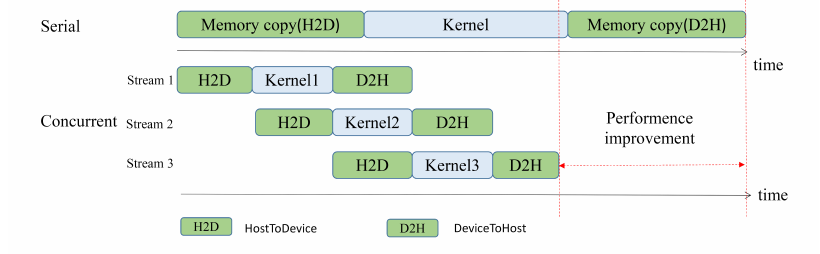
Figure 7. The principle of compute unified device architecture (CUDA) stream.